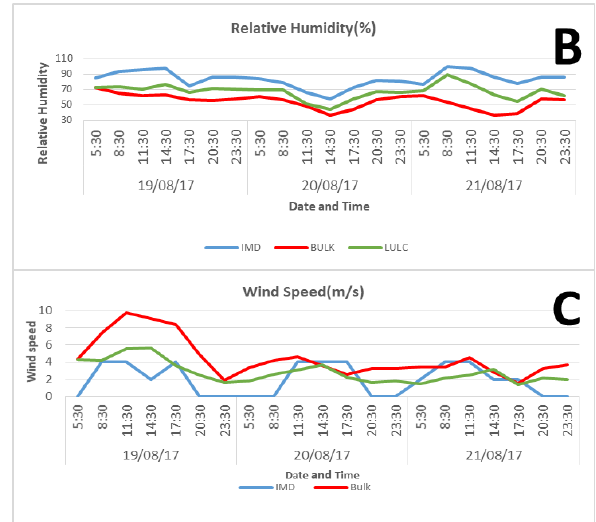
Figure 8 Comparison between observed and simulated A) Temperature B) Relative Humidity C) Wind Speed